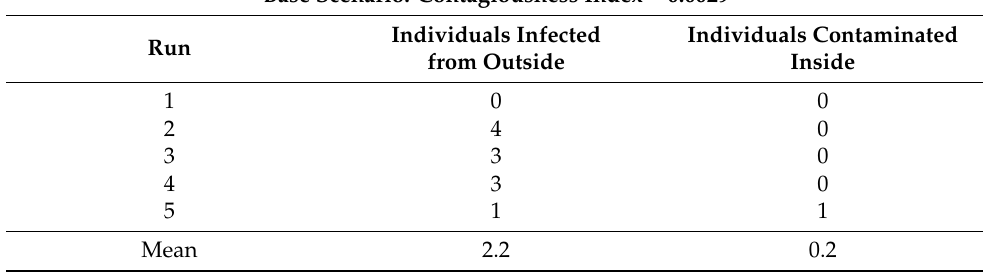
Table 7. Base scenario